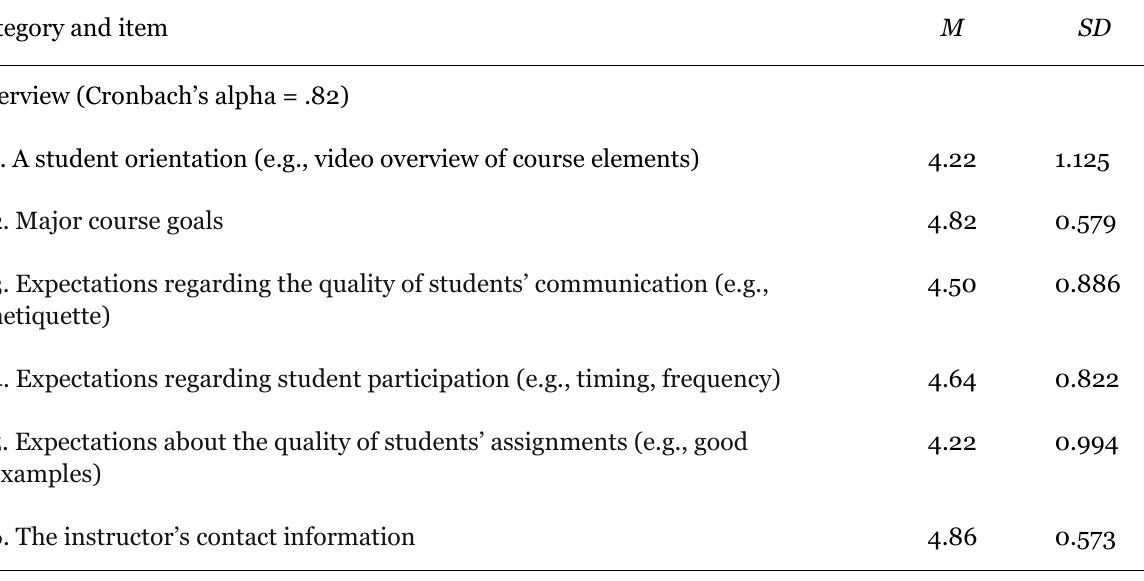
Means and Standard Deviations for Survey